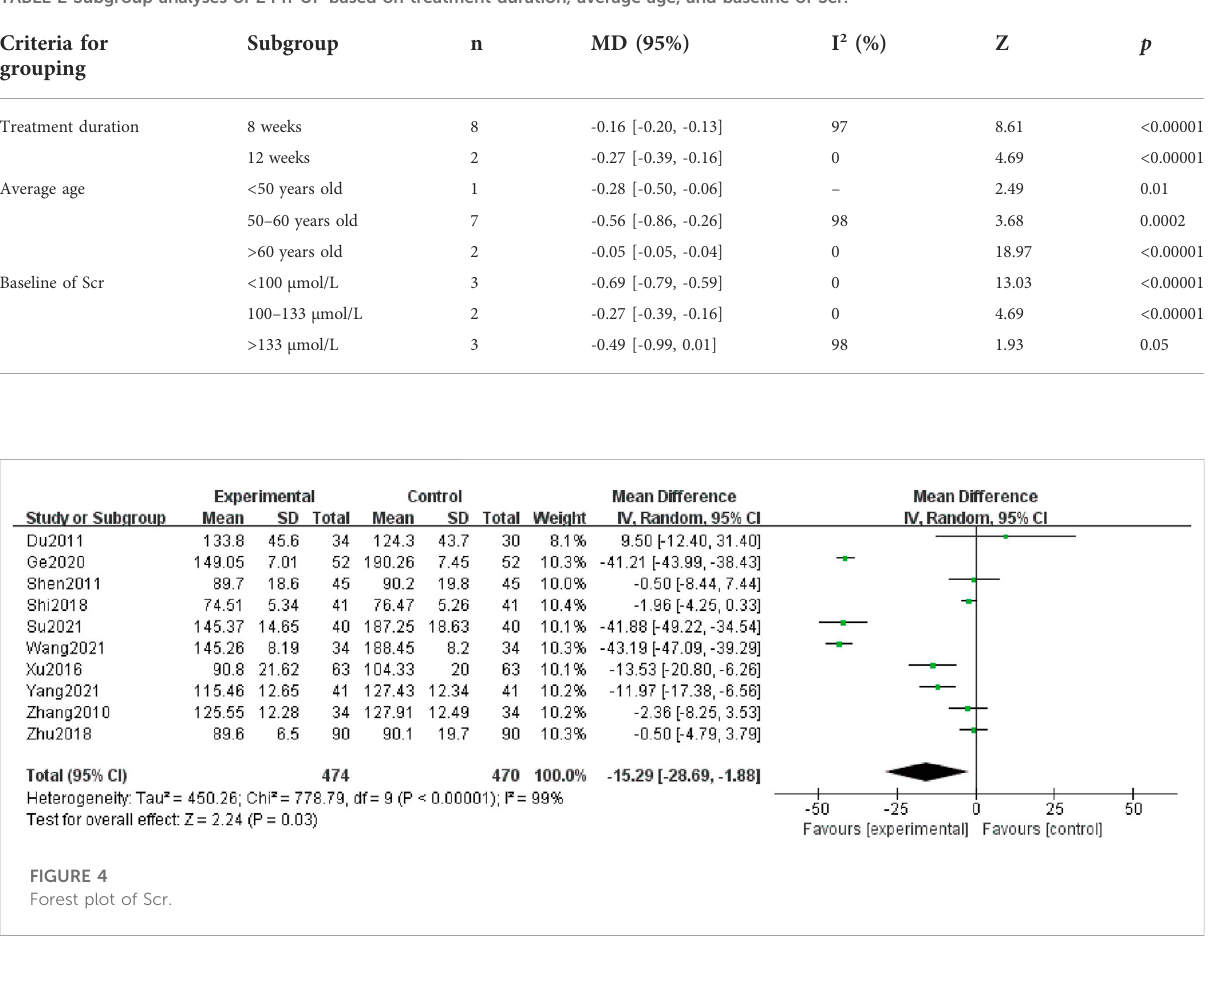
TABLE 3 Subgroup analyses of Scr based on treatment duration, average age, and baseline of Scr. Criteria for